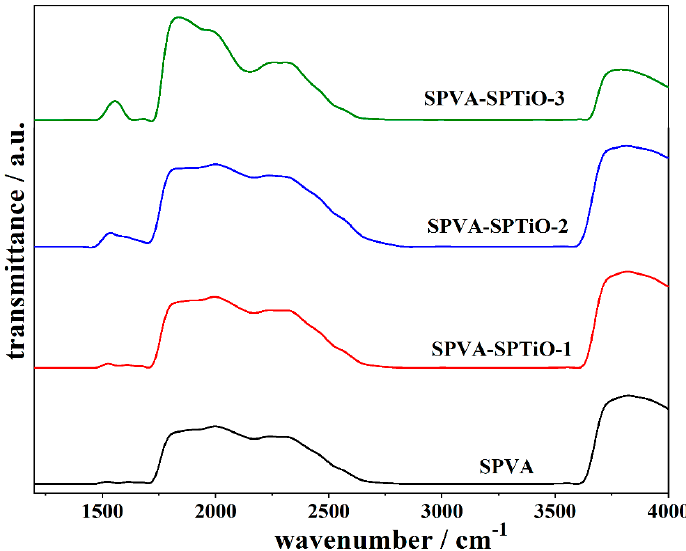
Figure 5. FTIR spectra of the SPVA-SPTiO membranes in the presence (different contents) and in the absence of PO 4 -TiO 2 and SO 4 -TiO 2 .